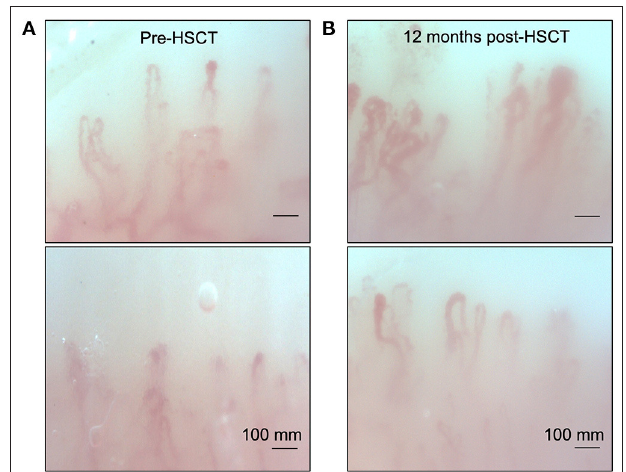
FIGURE 2 | On exam, the patient had no digital ulcers, but her hands were fixed in flexion, with sclerodactyly and a positive “prayer sign”. There is also evidence of skin tightness in the bilateral upper extremities extending to the elbows.